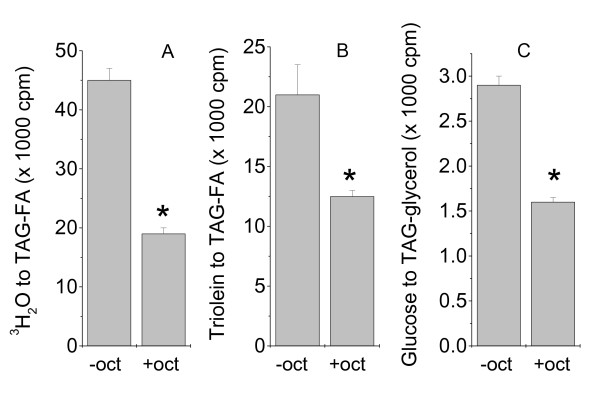
The effects of octanoate on lipogenesis in adipocytes. Six days after induction of differentiation, 3T3-L1 adipocytes were incubated with octanoate (1 mM, oct) mixed with DMEM containing 10% FBS and 170 nM insulin for 3 days. Exogenous octanoate were then removed and cells were incubated for 3 h in the same medium with 3H2O (A), [9,10-3H] triolein (B), and [U-3H] glucose (C). The incorporation of the corresponding isotope into the cellular TAG-fatty acids (TAG-FA, A&B) and TAG-glycerol (C) were measured. Data are mean +/- SE, n = 3. *p < 0.05 compared to control.